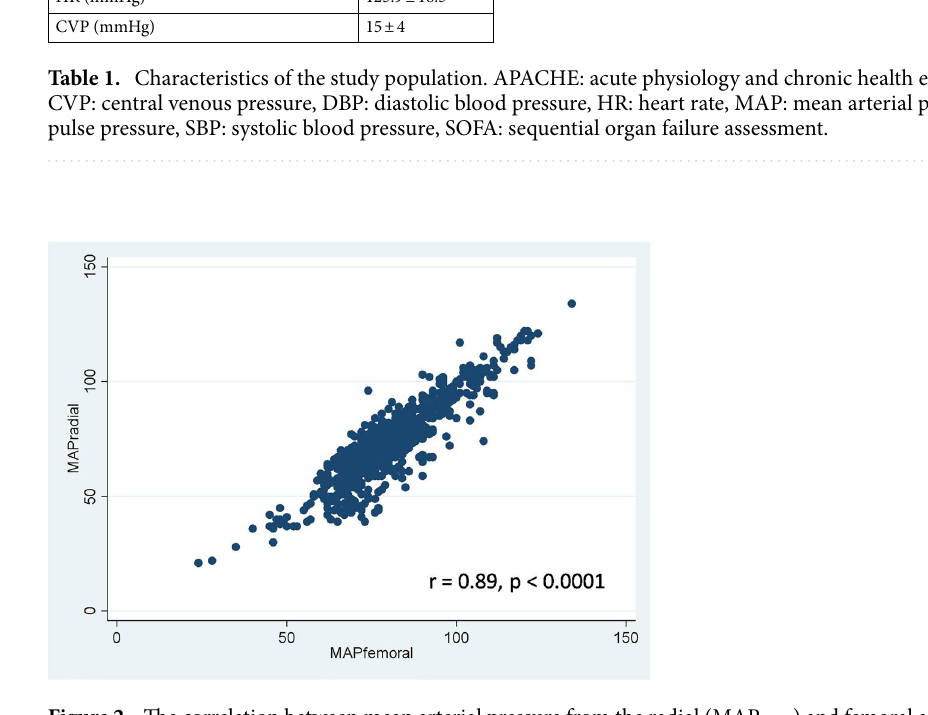
Figure 2. The correlation between mean arterial pressure from the radial (MAP radial ) and femoral artery (MAP femoral